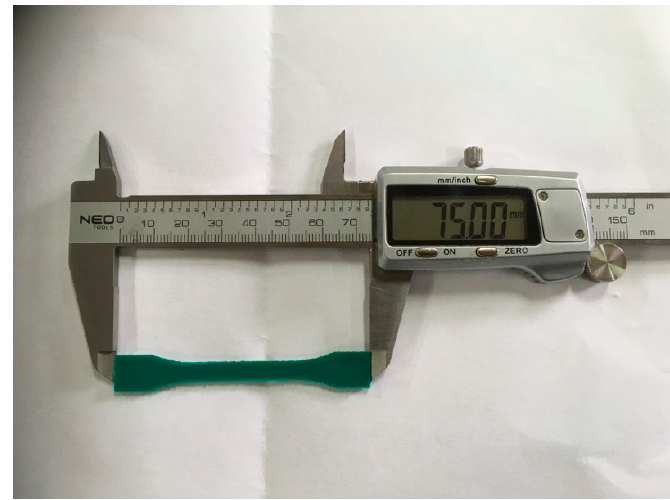
Figure 12. 1BA shaped specimen.